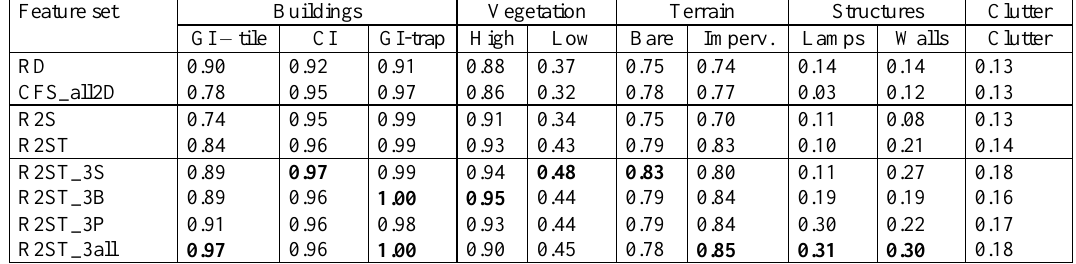
Table 7. Correctness of selected feature sets for the 10-class problem. (GI = galvanized iron, CI = corrugated iron, Imperv. = impervious) Feature set